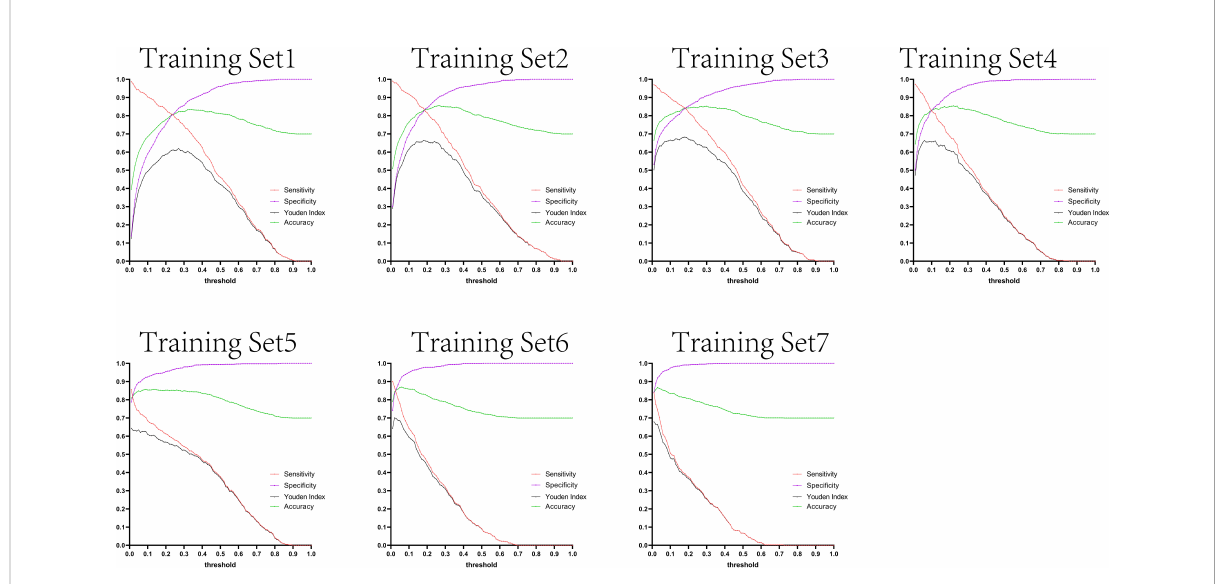
FIGURE 11 Curves of sensitivity, speci fi city, Youden index, and accuracy with threshold after test set 2 was tested separately by seven training set models.